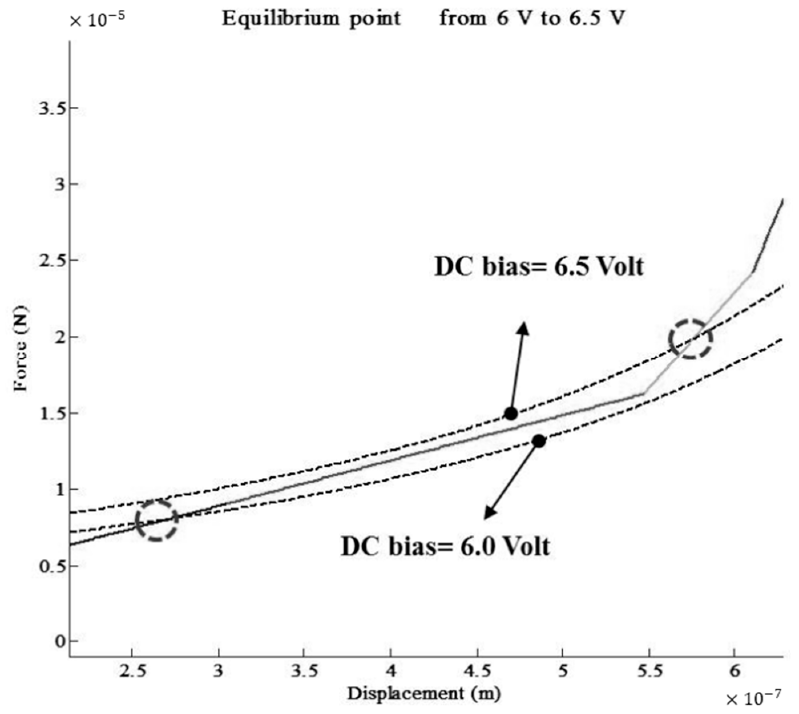
as shown in Figure 8.